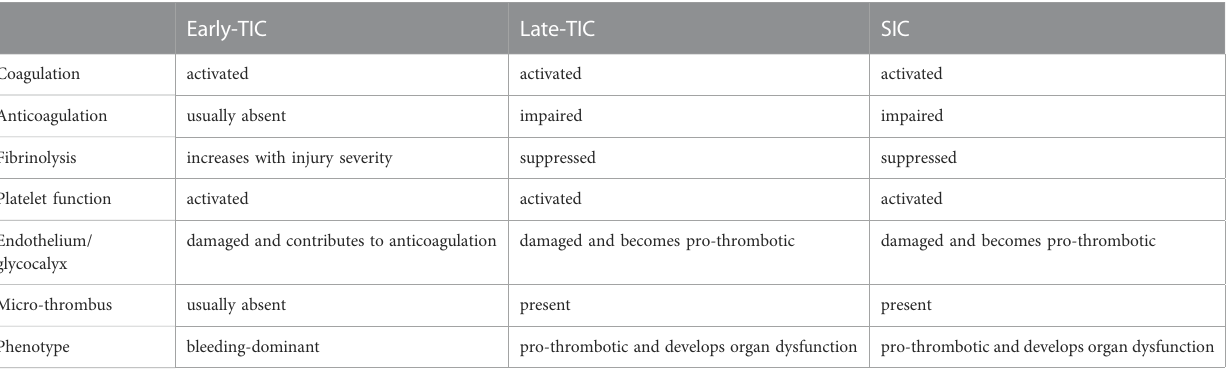
TABLE 3 Contrasting hemostatic changes in TIC and